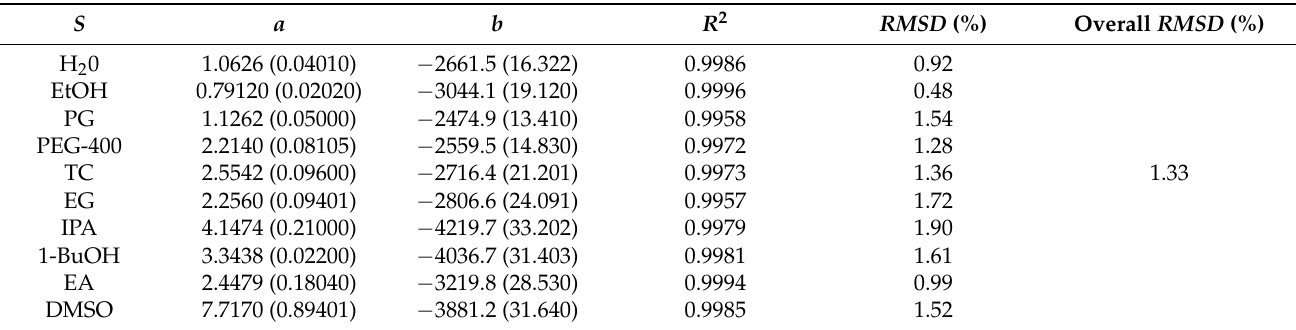
Table 3. Results of Van’t Hoff model in terms of model parameters ( a and b ), R 2 and % RMSD values for TMZ in various solvents ( S ) (values in parentheses are standard